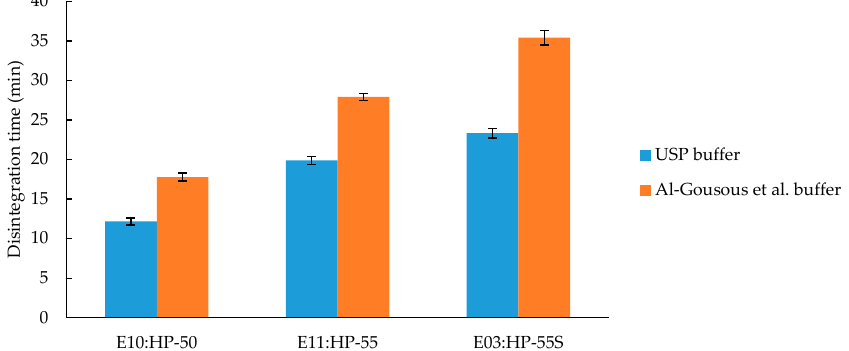
Figure 6. Disintegration time of capsules coated with HPMCP of different grades (HP-50, HP-55, and HP-55S). Given are average disintegration times ± SD; n = 6.